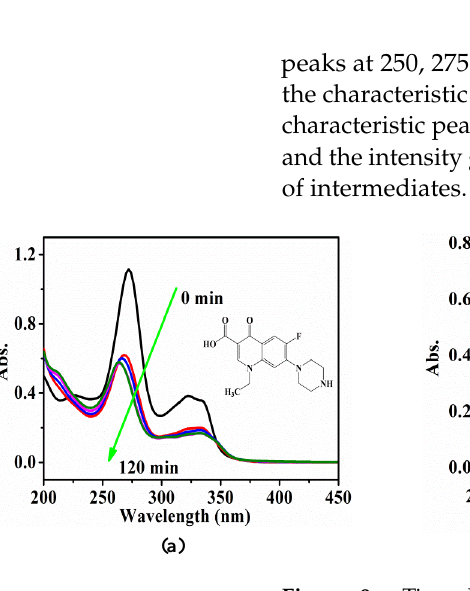
Figure 9. Time-dependent UV – vis spectra of ( a ) NOR, ( b ) SMX and ( c ) TCH solution for Ag/CNQDs/g-C 3 N 4 composites.